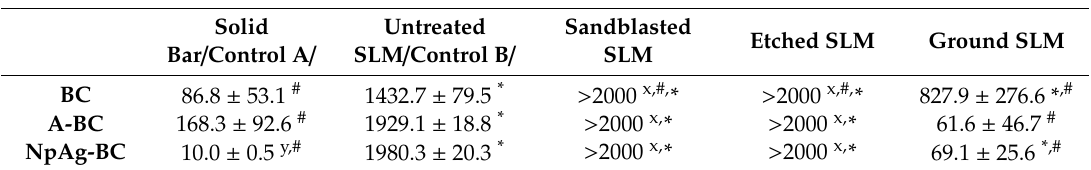
Table 7. Adhesion of bone cements to surface-modified titanium alloy specimens (n = 5; data are the means ± SD; * significantly di ff erent from control A ( p < 0.05); # significantly di ff erent from control B ( p <